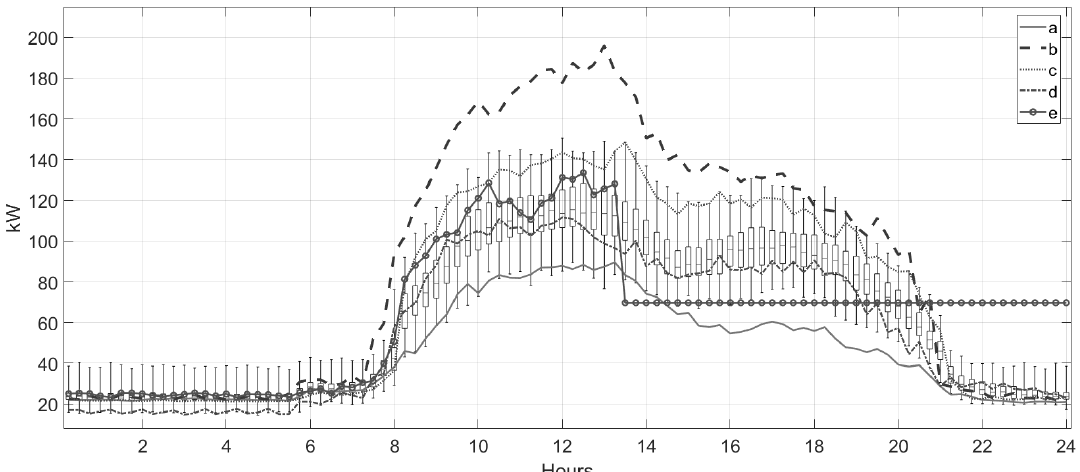
Figure 17. Electrical consumption profiles according to the seasonality analysis of electricity consumption method. Note: (a) day of anomalous low consumption; (b) day of anomalous high consumption; (c) day of typical high consumption; (d) day of typical low consumption; and (e) day with measurement